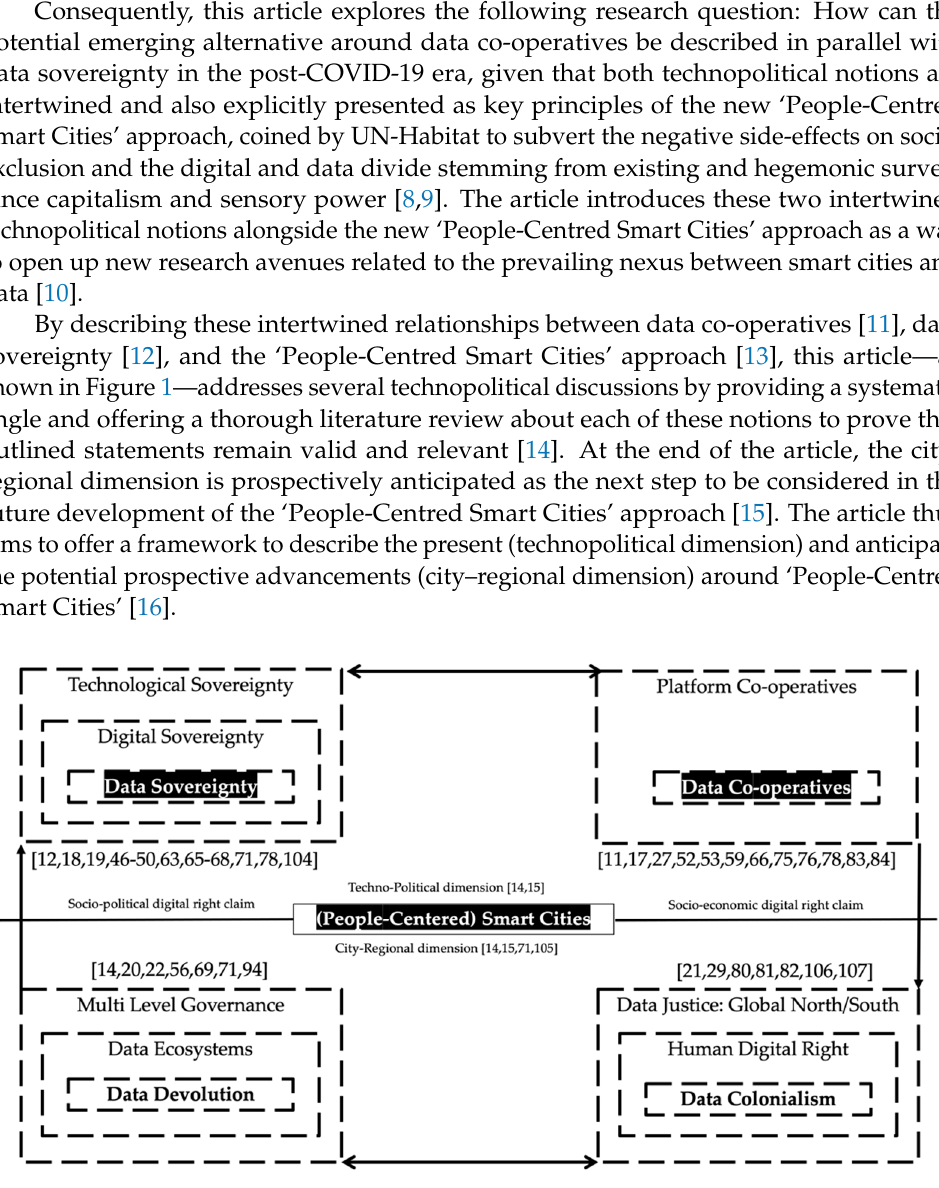
Figure 1. Framework, structure, and literature review: technopolitical dimension of the ‘People- Centred Smart Cities’ consisting of data co-operatives through data